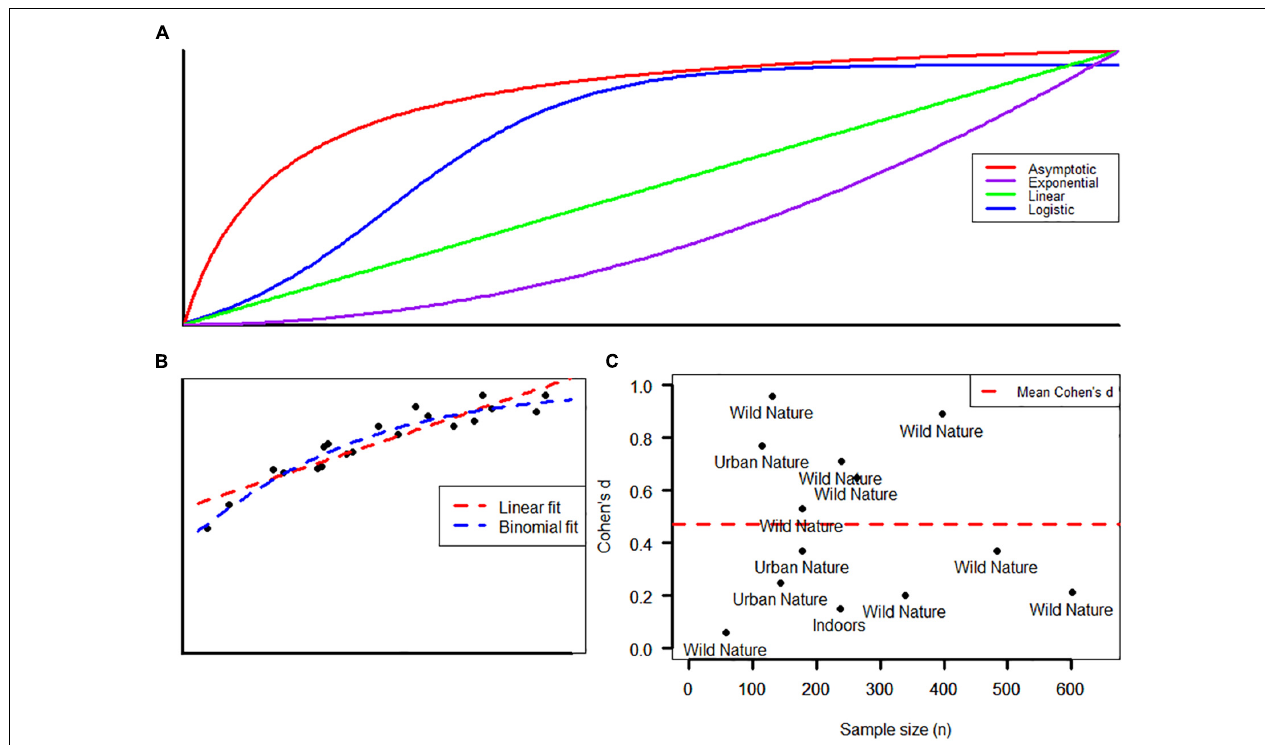
FIGURE 1 | (A) Non-linear responses to an intervention. (B) A poorly fitted linear model and a better fit logistic/binomial model to a simulated curved dataset. (C) Standardized effect with increasing sample size, environment type as a text label.